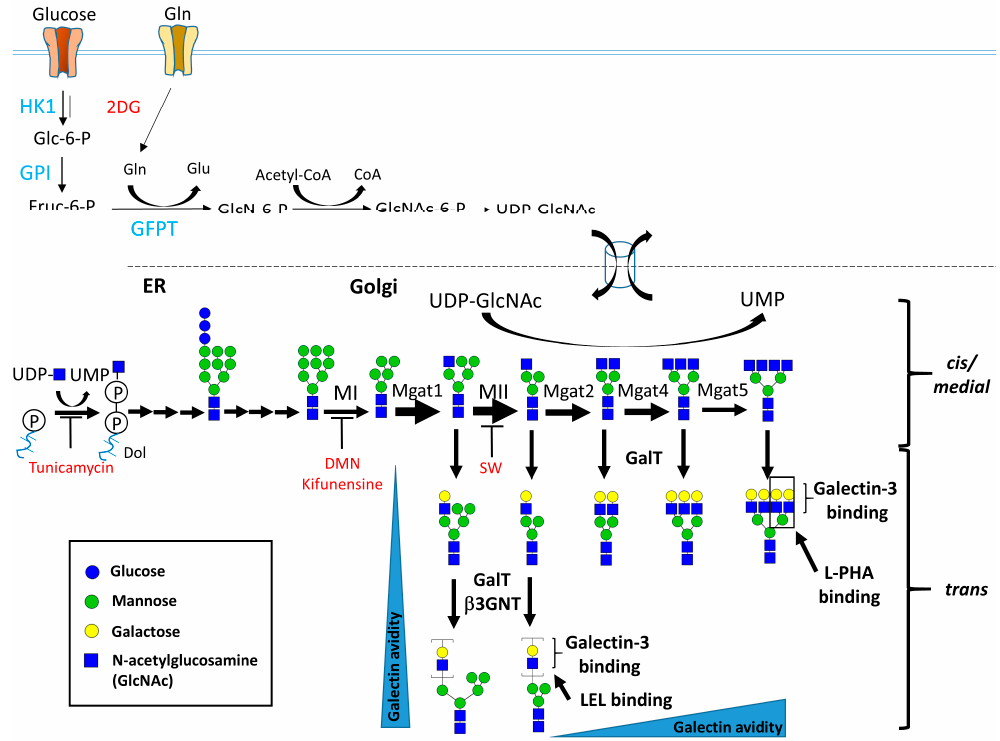
Figure 1. Biosynthesis of N -glycan branching. The UDP-GlcNAc supply is sensitive to glucose (Glc), glutamine (Gln), acetyl-CoA, and GlcNAc. UDP-GlcNAc is required for the initiation of N -glycans in the ER and is used for branching reactions in the Golgi. N -glycan branching is achieved via a series of glycohydrolase- and Mgat-mediated reactions. These N -glycans are further elongated with LacNAc units, which interact with galectin-3. These complex N -glycans are capped by sialic acid and fucose via the action of sialyltransferases and fucosyltransferases, respectively. 2DG = 2-deoxy- D -glucose, Dol = Dolichol, DMN = deoxymannojirimycin, MI = mannosidase I, MII = mannosidase II, SW = swainsonine. Additional structural modification via addition of sialic acid, fucose, N -acetylgalactosamine and/or sulfate is not shown.